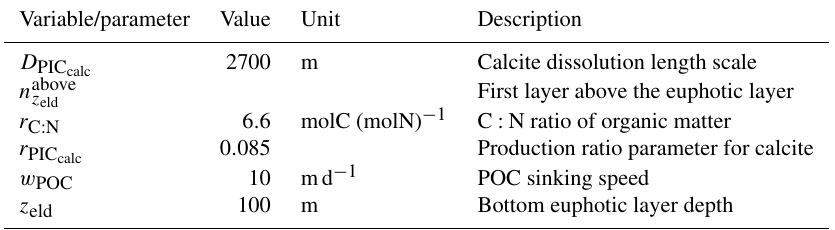
Table C2. CMOC parameters.